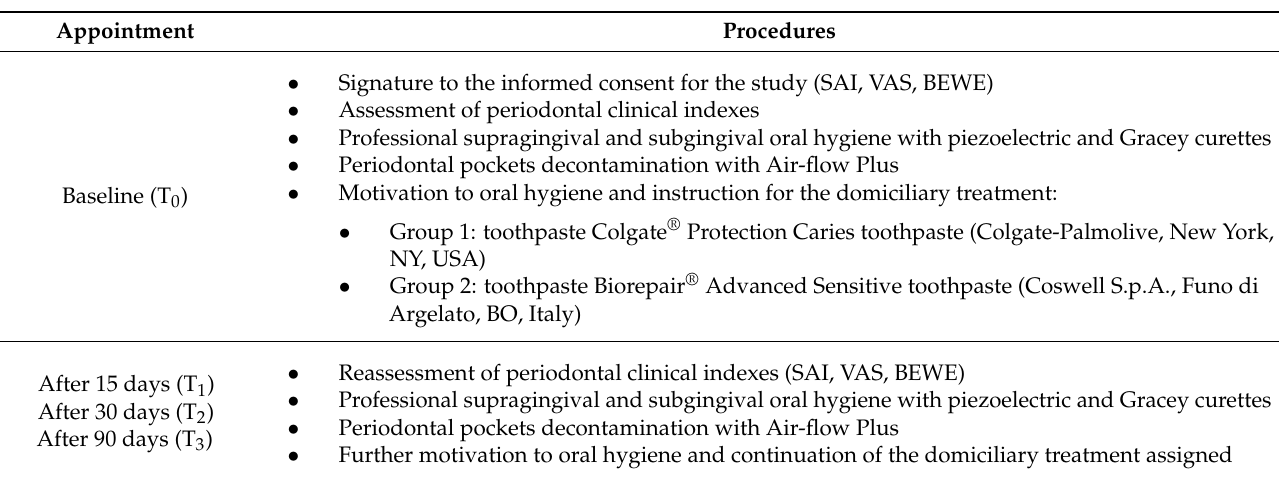
Table 2. Protocol of the